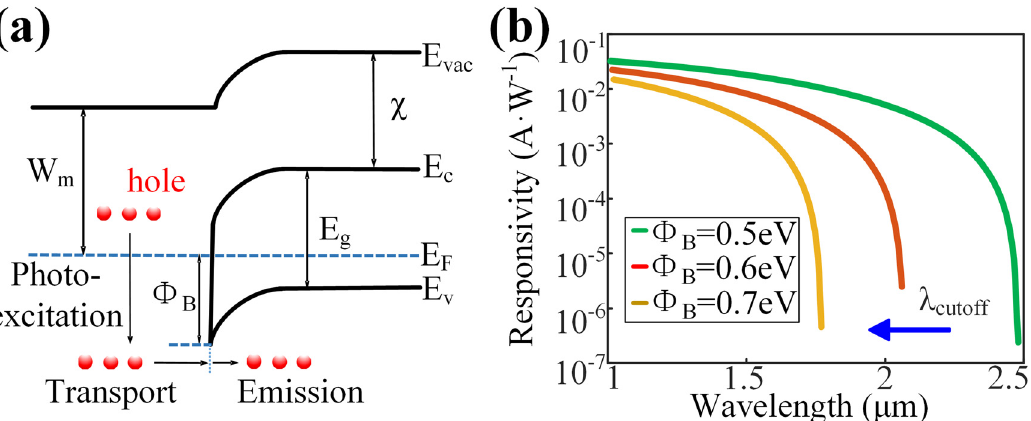
Figure2: (a)TheenergybanddiagramoftheTi 3 C 2 T x /p-SiSchottkyjunctionuponillumination.Here, E vac , E c ,and E v standforthevacuumlevel, the bottom of the conduction band, and the top of the valence band, respectively. E F corresponds to the Fermi energy in the silicon at thermal equilibrium. Φ B is the barrier height between Ti 3 C 2 T x and p-Si, W m is the work function of Ti 3 C 2 T x , χ is the electron af fi nity of p-Si, and E g is the bandgap of p-Si. (b) The computed responsivity of the ideal Ti 3 C 2 T x /p-Si Schottky photodetector with a different barrier Φ B .